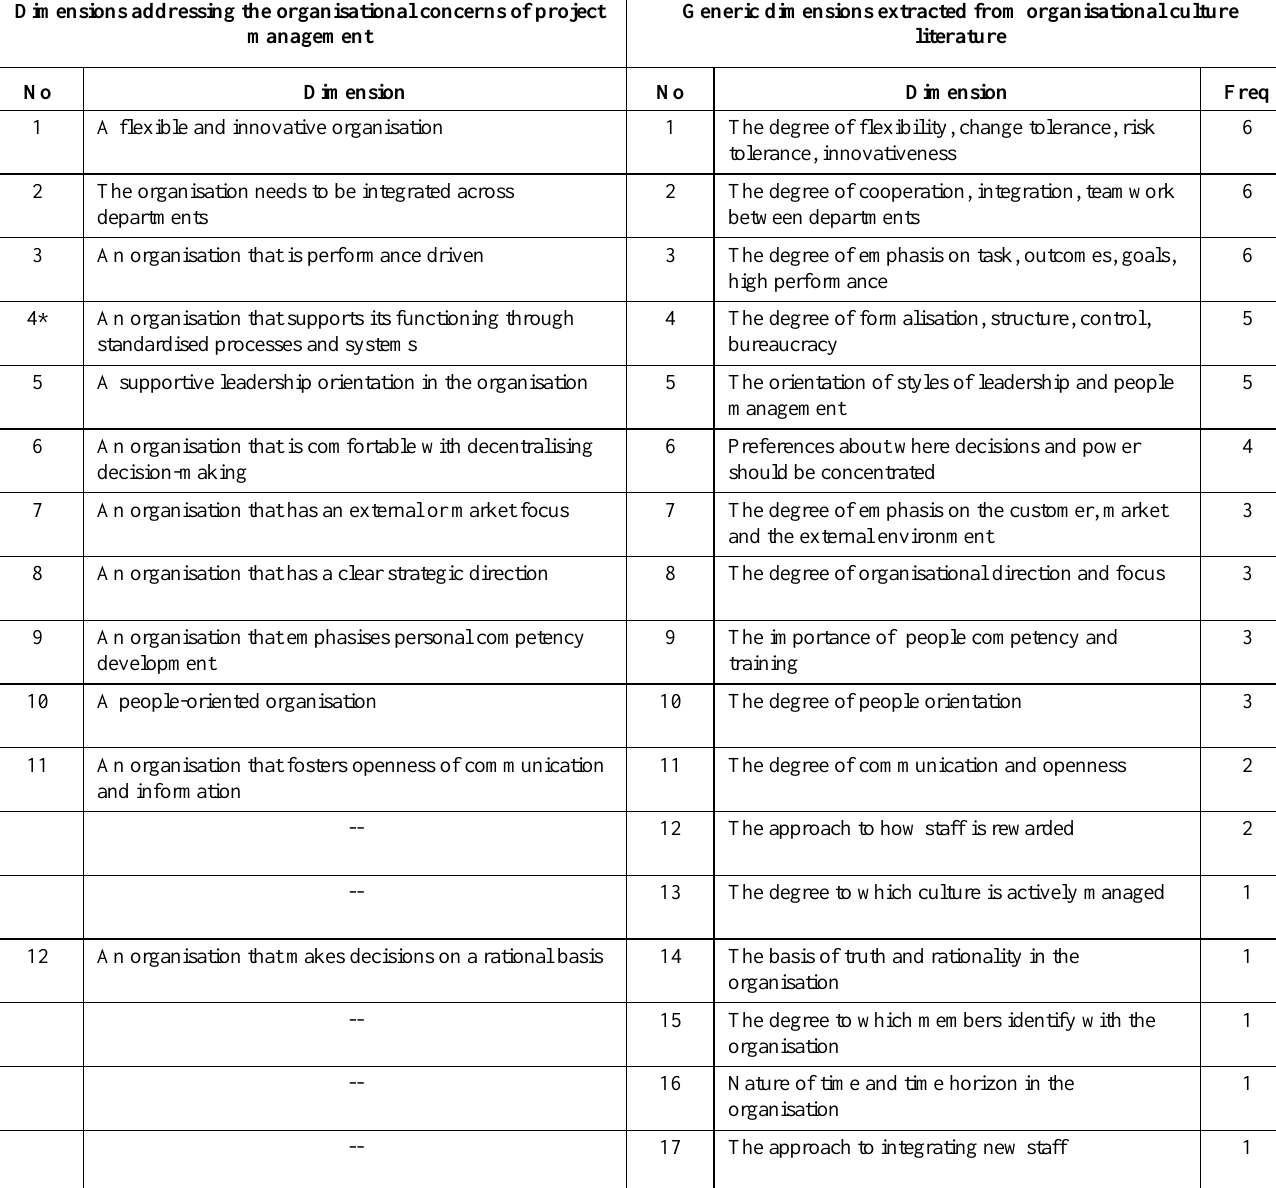
Table 14: Matching the project management dimensions with the generic organisational culture dimensions Dimensions addressing the organisational concerns of